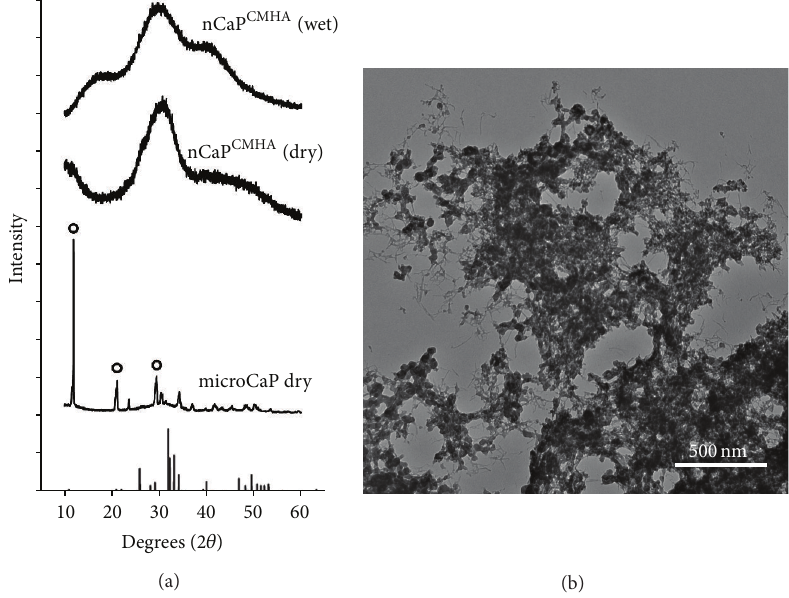
Figure2:PhysicalcharacterizationofnCaP CMHA usingX-raydiffractionandtransmissionelectronmicroscopy.(a)XRDspectraofnCaP CMHA suspension (nCaP CMHA wet), lyophilized nCaP CMHA (nCaP CMHA dry), and lyophilized CaP without stabilizer added during precipitation (microCaP dry). Hydroxyapatite standard (JCPDS, #09-0432, bars) is shown for comparison. nCaP CMHA both wet and dry has a major broad